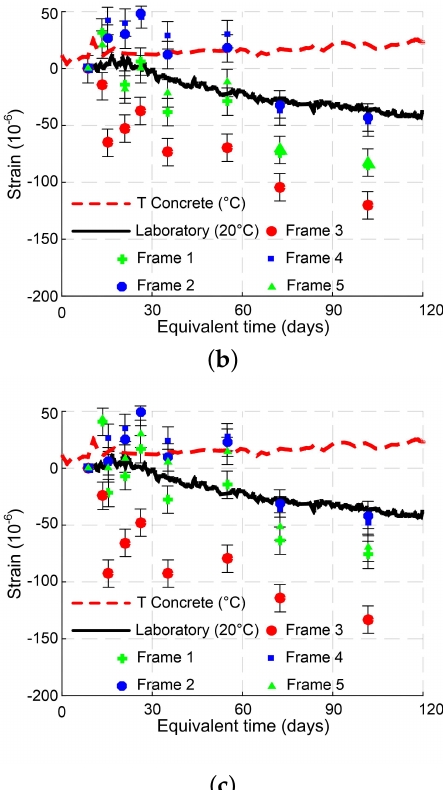
Figure A1. Strain measurement in concrete during concrete shrinkage for the whole sensors. ( a ) Strain measurement in the top level; ( b ) Strain measurement in the middle level; ( c ) Strain measurement in the bottom